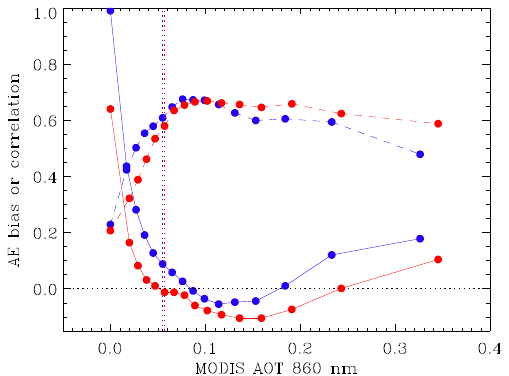
Fig. 11. Bias and correlation of MODIS AE vs. AERONET AE for Aqua (blue) and Terra (red). Bias and correlation were calcu- lated for MODIS AOT at 860nm bins. The horizontal axis shows the lower AOT value of each bin. Bins contain equal numbers of observations (per bin 6.25% of all observations). The vertical lines are the chosen